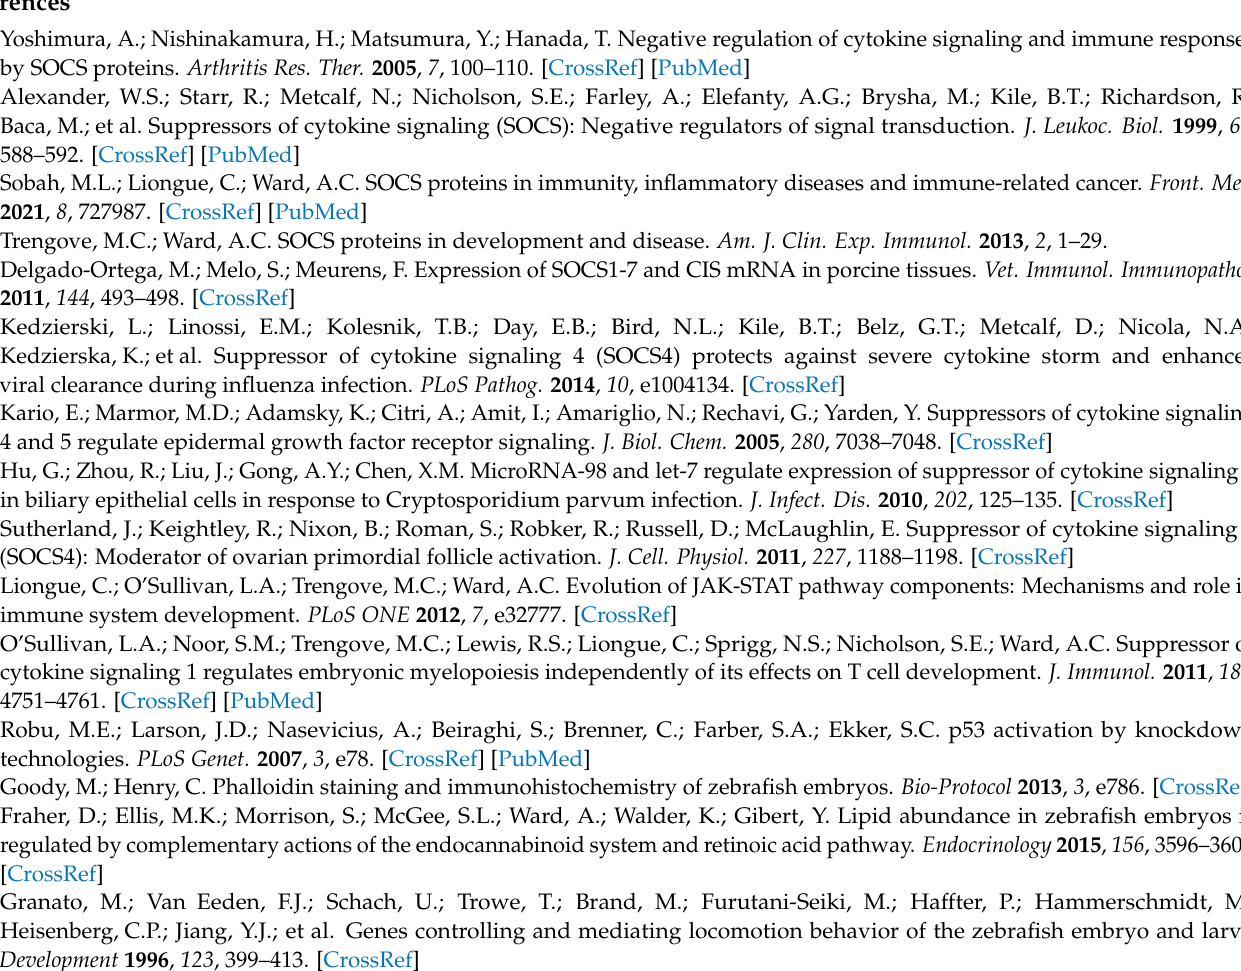
Figure S2: Confirmation of efficacy of socs4a ATG